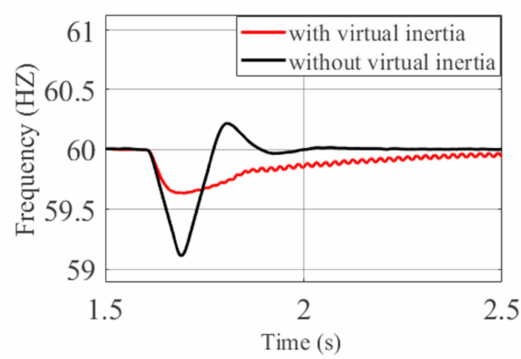
Figure 18. System frequency with and without virtual inertia.